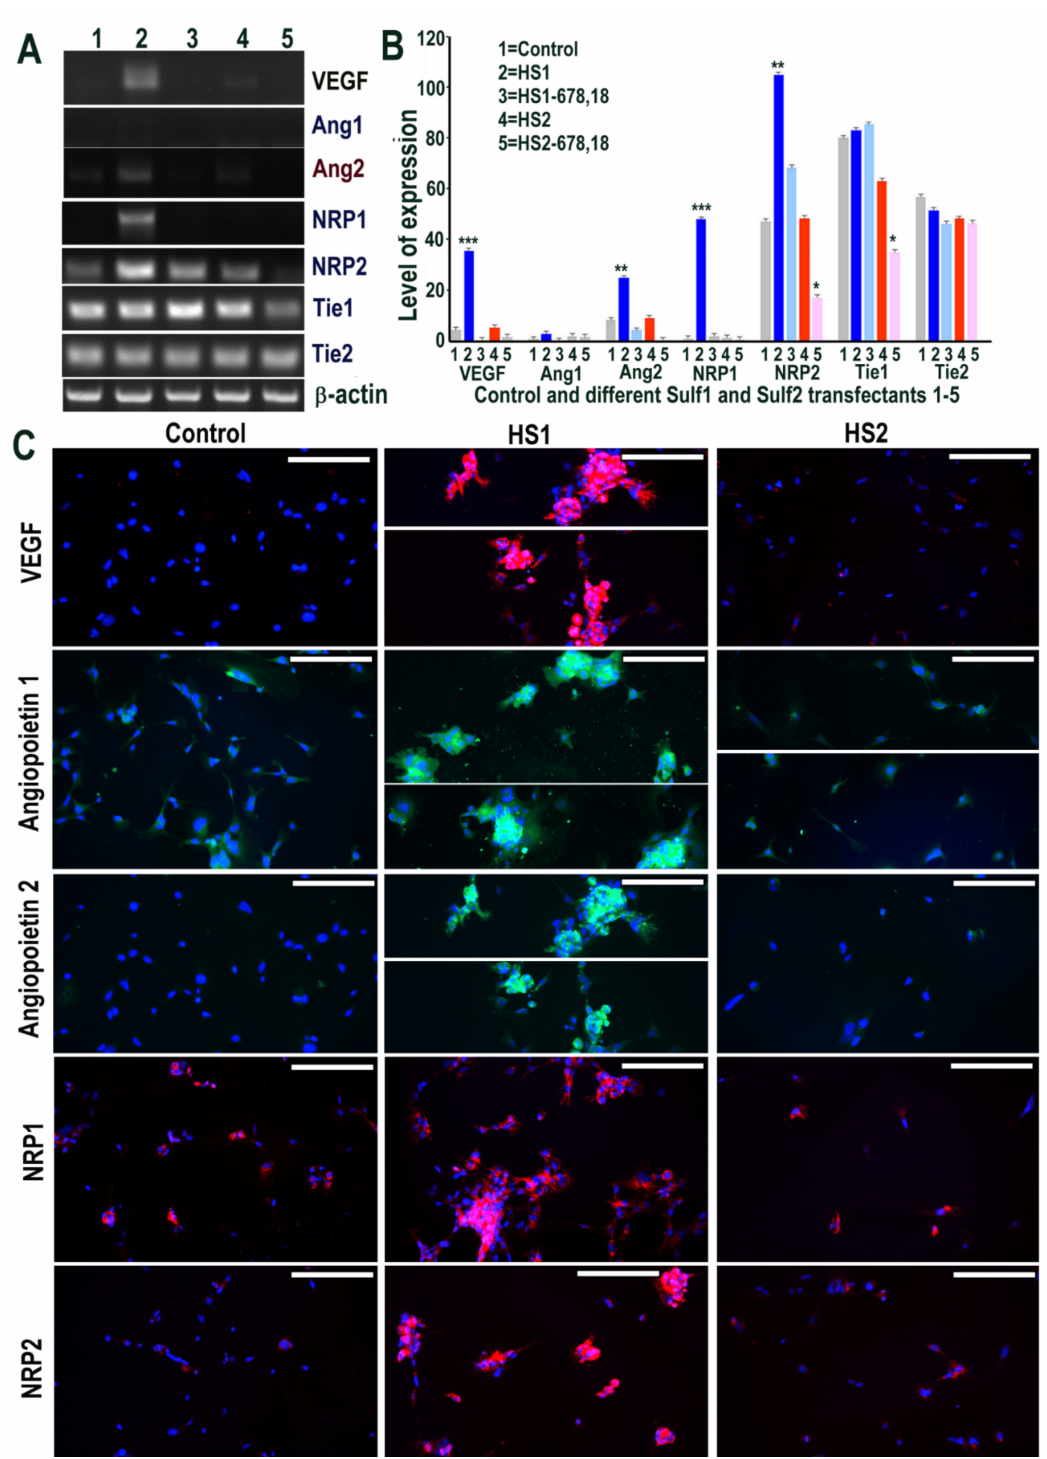
Figure 3. ( A , B ) Selective changes in levels of VEGF cell signalling including its receptors (Ang1, Ang2, NRP1, NRP2, Tie1 and Tie2) following transfections of HMec1 cells with (1) pcDNA3, (2) full length Sulf1 (HS1), (3) shorter inactive Sulf1 (HS1-678,18), (4) full length Sulf2 (HS2) and shorter inactive Sulf2 (HS2-678,18) examined by RT PCR analysis and quantified using Image J analysis. Error bars = means ± SD; *** p < 0.0001; ** p < 0.001; * p < 0.01. ( C ) Changes in VEGF cell signalling following transfections were also confirmed by immunostaining for VEGF, Ang1, Ang2, NRP1, NRP2 using immunofluorescence procedure. Scale bar = 100 µ